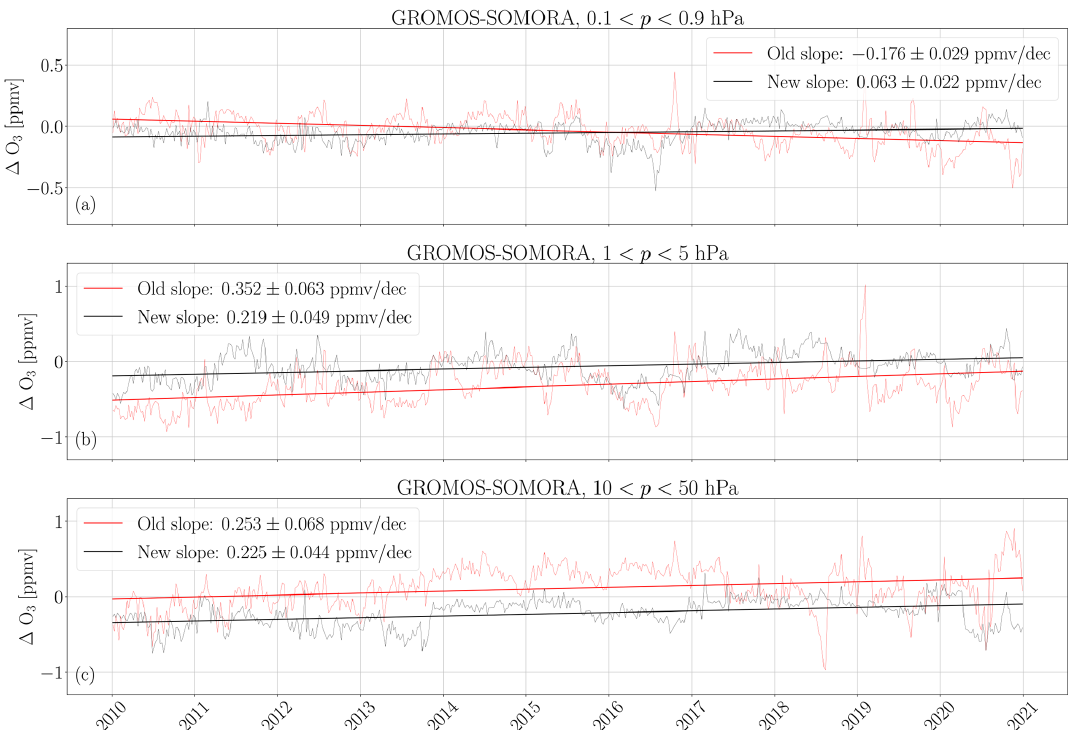
Figure 9. Weekly ozone differences between the previous and the new GROMOS and SOMORA series for the three pressure levels defined in Table 4: (a) lower mesosphere, (b) upper stratosphere and (c) lower stratosphere. A linear fit of the differences is shown as a straight line for the previous and the new series. The slope values are indicated with a 95% confidence